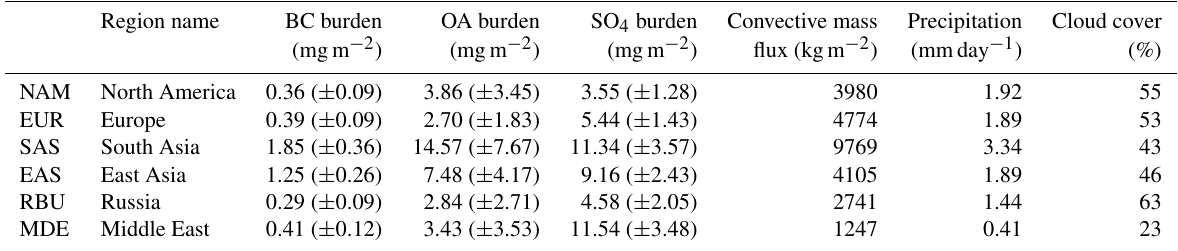
Table 2. Regionally averaged burdens and climatological features for the six source regions. Burdens are multi-model median, annually averaged values for the BASE experiment with 1 multi-model standard deviation in parentheses. Convective mass flux (for the layers be- tween 1000 and 500hPa), precipitation and cloud cover represent regionally and annually averaged values for 2010 from the Modern-Era Retrospective analysis for Research and Applications (MERRA) reanalysis data